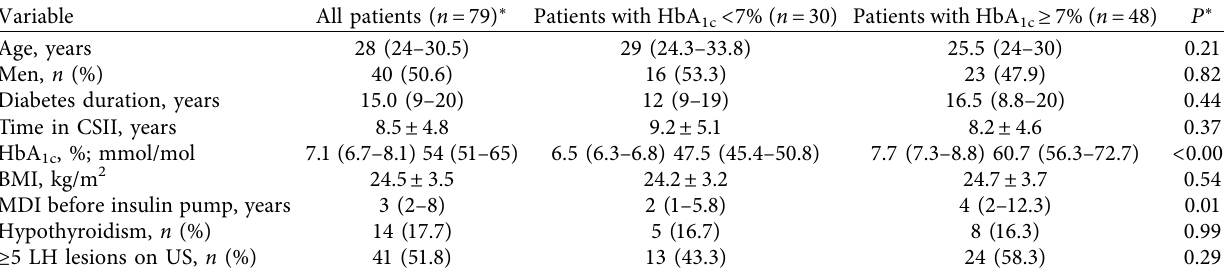
Table 1: Patients